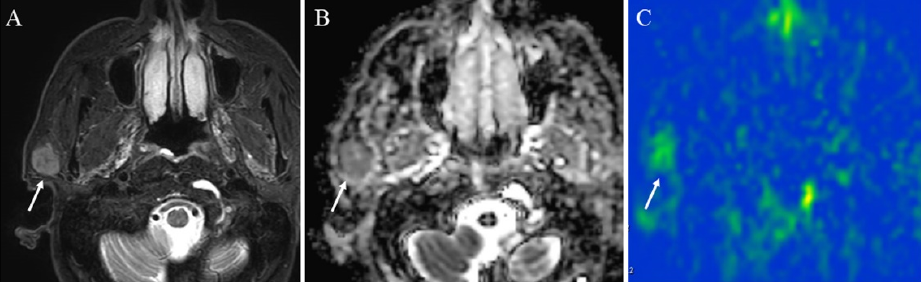
Figure 9. A 72-year-old male with acinic cell carcinoma of the right parotid gland: ( A ) STIR shows a mass with high signal intensity (arrow); ( B ) ADC map shows mild restricted diffusion (arrow) (ADC 10th percentile, 0.93 × 10 − 3 mm 2 /s and ADC mean of 1.03 × 10 − 3 mm 2 /s); ( C ) pCASL image shows high TBF (arrow) (TBF 50th percentile, 34.26 mL/100 g/min).